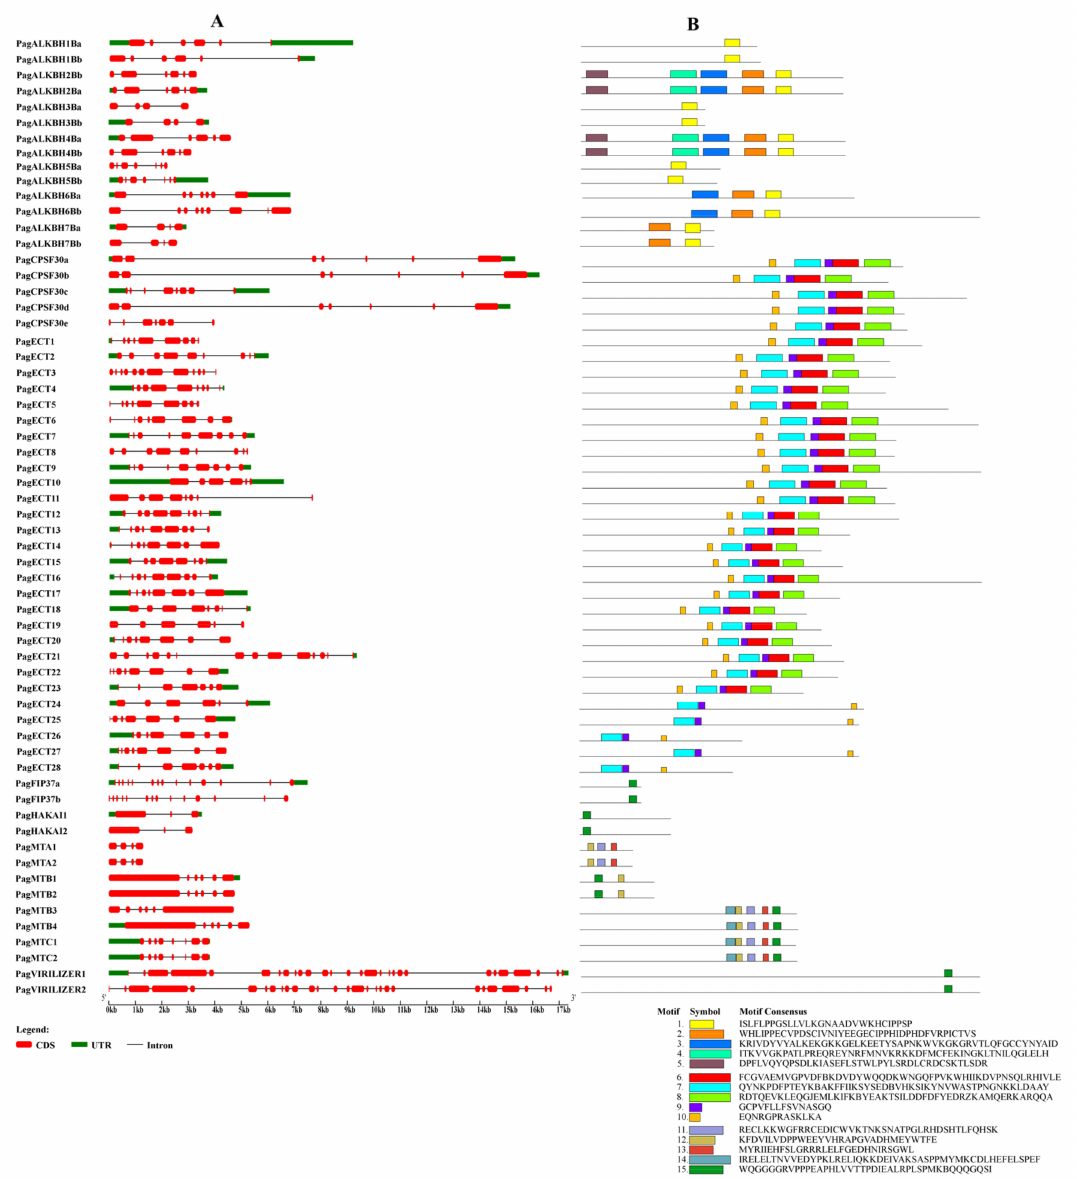
Figure 3. The gene structure and conserved motifs of m 6 A pathway genes. ( A ) Exons, UTRs, introns and intron phases are shown. ( B ) Motifs are represented by